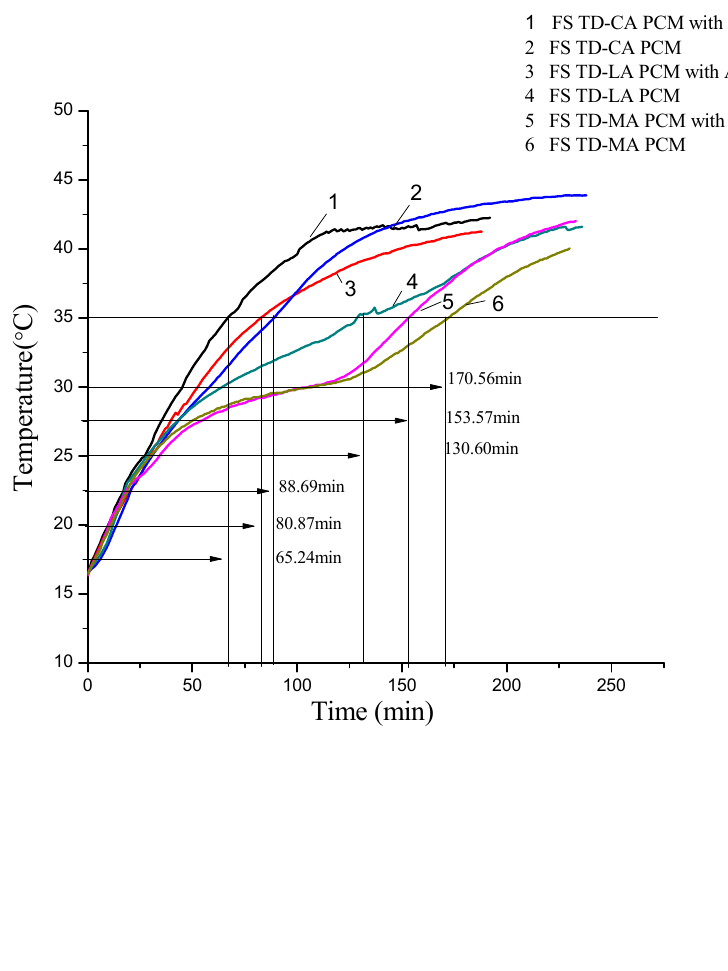
Figure 14. Comparison diagram of melting temperature curves between FS TD-CA PCM, FS TD-LA PCM, and FS TD-MA PCM with/without